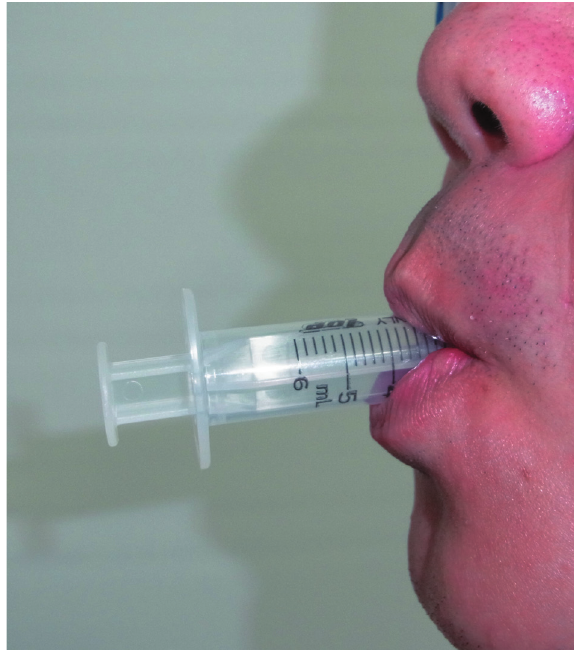
Figure 1- Collection of acetaldehyde. Participants